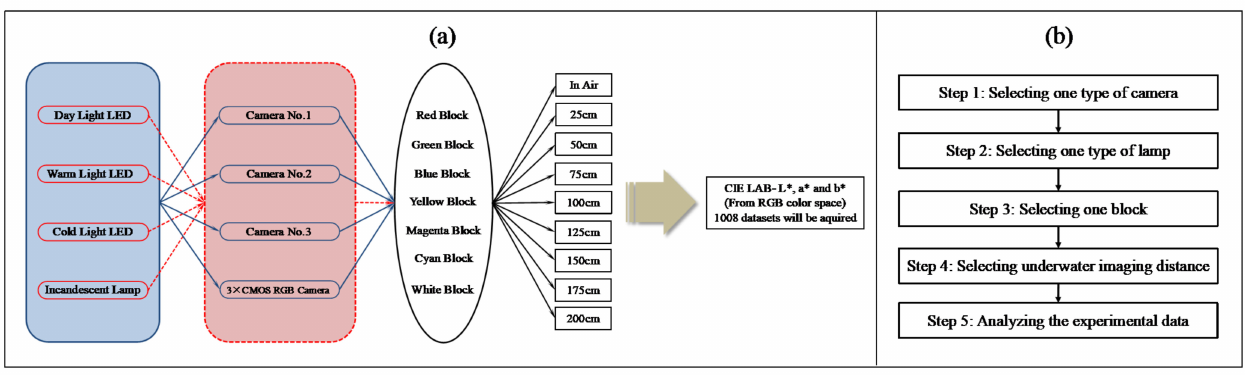
Figure 7. The experimental process: ( a ) the process of setting experimental parameters; ( b ) the flow chat of experimental process.